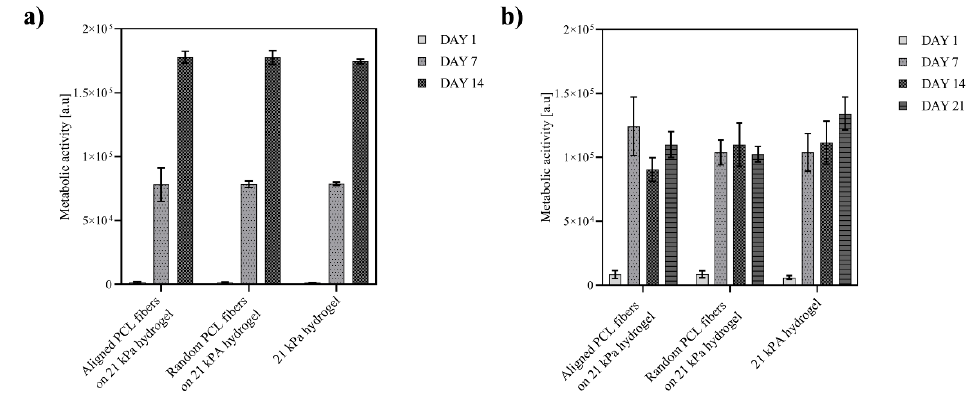
Figure 4. Neural progenitor cells and committed neurons on PCL-gelatin scaffolds. Cell viability (determined by Alamar Blue assay) of ( a ) ReN VM cells proliferated for 14 days and ( b ) committed neurons for 21 days on hydrogels and hybrid (aligned or randomly distributed) fibers on hydrogel scaffolds; number of hydrogels N = 9.